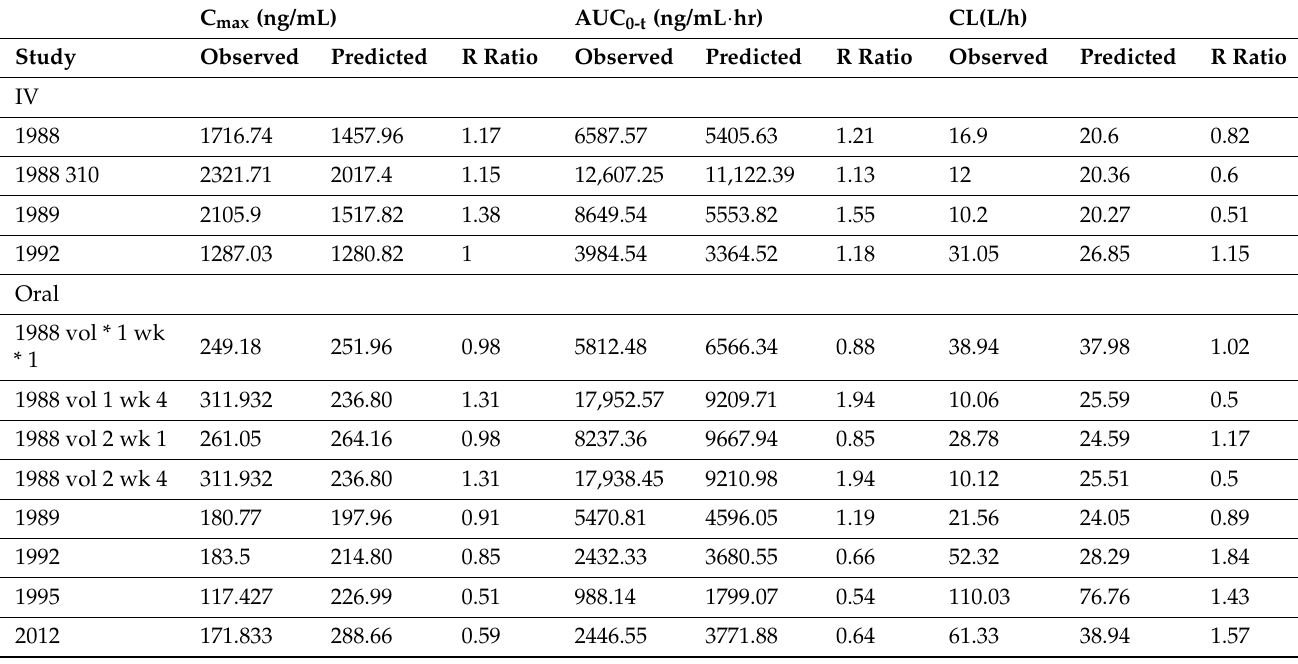
Table 3. Mean R obs /R pre ratios of various pharmacokinetic parameters after intravenous and oral administration of hydroxychloroquine in the healthy population.